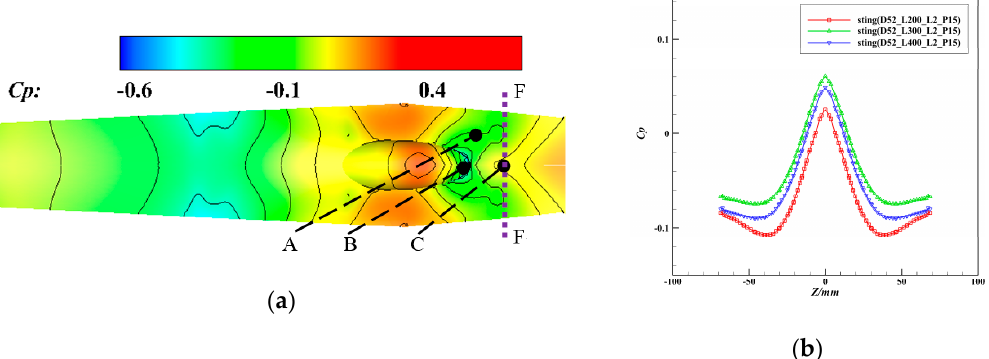
Figure 10. Pressure contour and distribution of the BWB aircraft with different straight-section lengths (L = 200 mm/300 mm/400 mm, Ma = 0.75, α = 0°): ( a ) pressure contour of the BWB aircraft under the L = 200 mm condition; ( b ) pressure distribution of profile F-F (position of F-F is shown in Figure 10a).